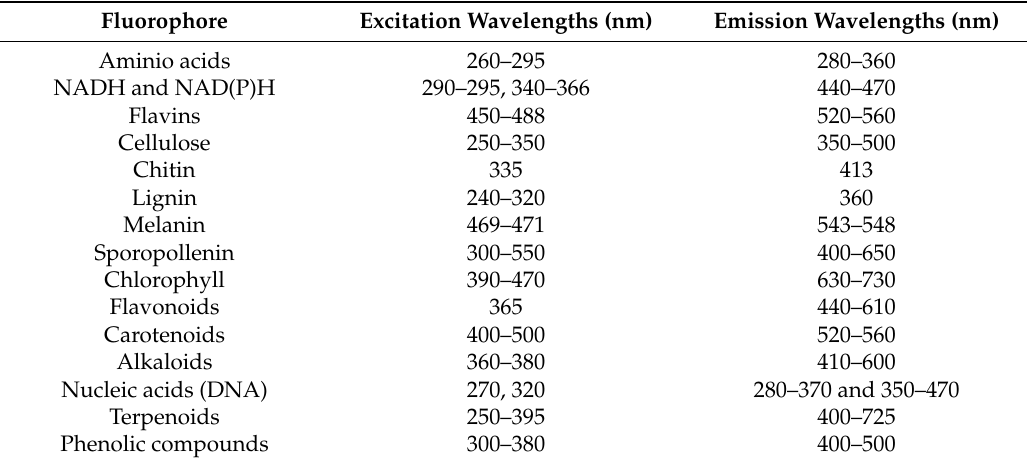
Table 1. Table of fluorophore excitation and emission